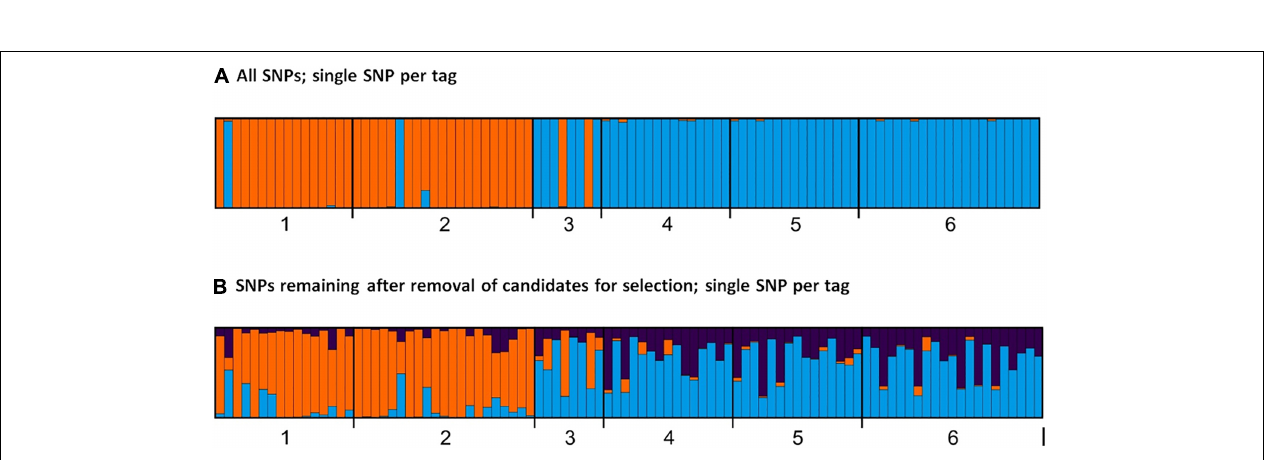
FIGURE 6 | Bar plots from STRUCTURE showing with genetic clustering of sub-populations based on ddRAD SNP analysis, with one SNP selected per RADtag for each run, for numbers of clusters, K = 2 and K = 3. (A) Analysis of all 3,455 SNPs from 1,957 RADtags. (B) Analysis of SNPs deemed to be neutral, including 3,438 SNPs from 1955 RADtags. Genetic clusters are represented by colors; bar graphs show average probability of membership ( y -axis) of each individual; regions are defined by thick vertical lines. There is a strong differentiation between the Pacific Arctic (Beaufort Sea and Chukchi Borderland) and the Atlantic Arctic (Fram Strait and Labrador Sea) in both graphs. Key: 1: Beaufort Sea; 2: Chukchi Borderland; 3: Amerasian Basin; 4: Eurasian Basin; 5: Fram Strait; 6: Labrador